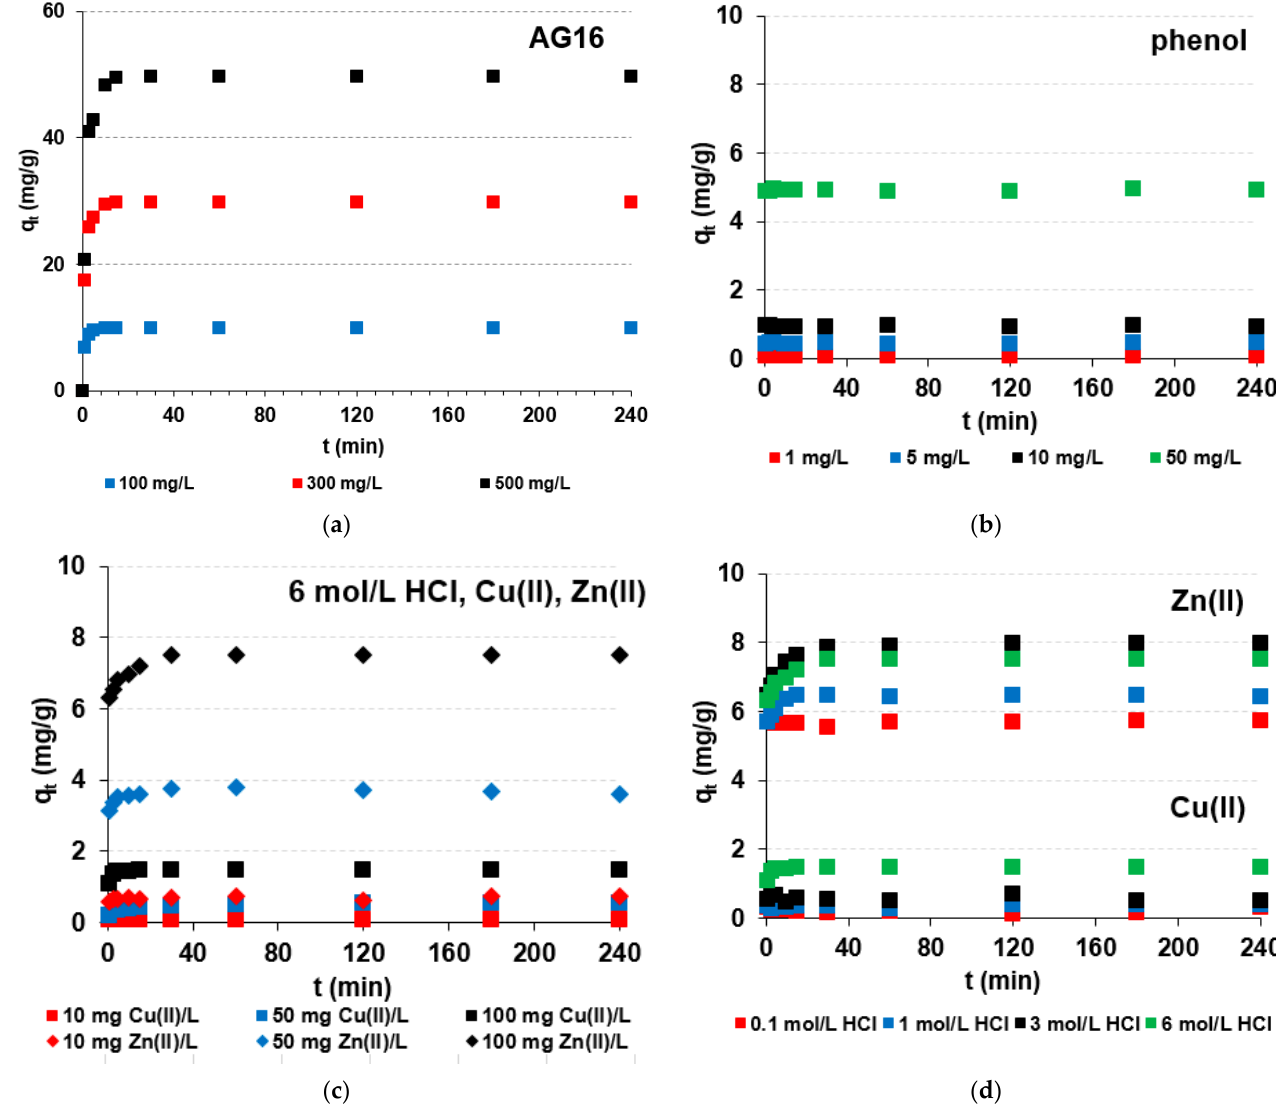
Figure 3. Kinetic plot in the adsorbate-S5528 systems. Impact of ( a–d ) phase contact time, initial concentrations of ( a ) AG16, ( b ) phenol and ( c ) metal ions, as well as ( d ) HCl concentration on Zn(II) and Cu(II) removal ( C 0 = 100 mg/L).